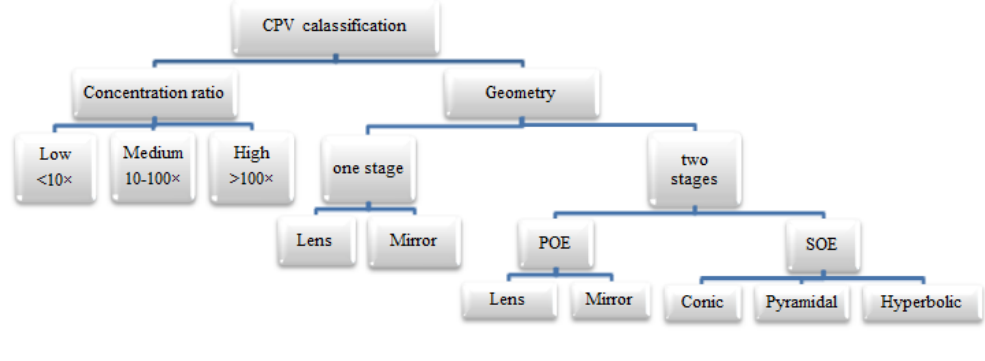
Figure 5. Classification of CPV